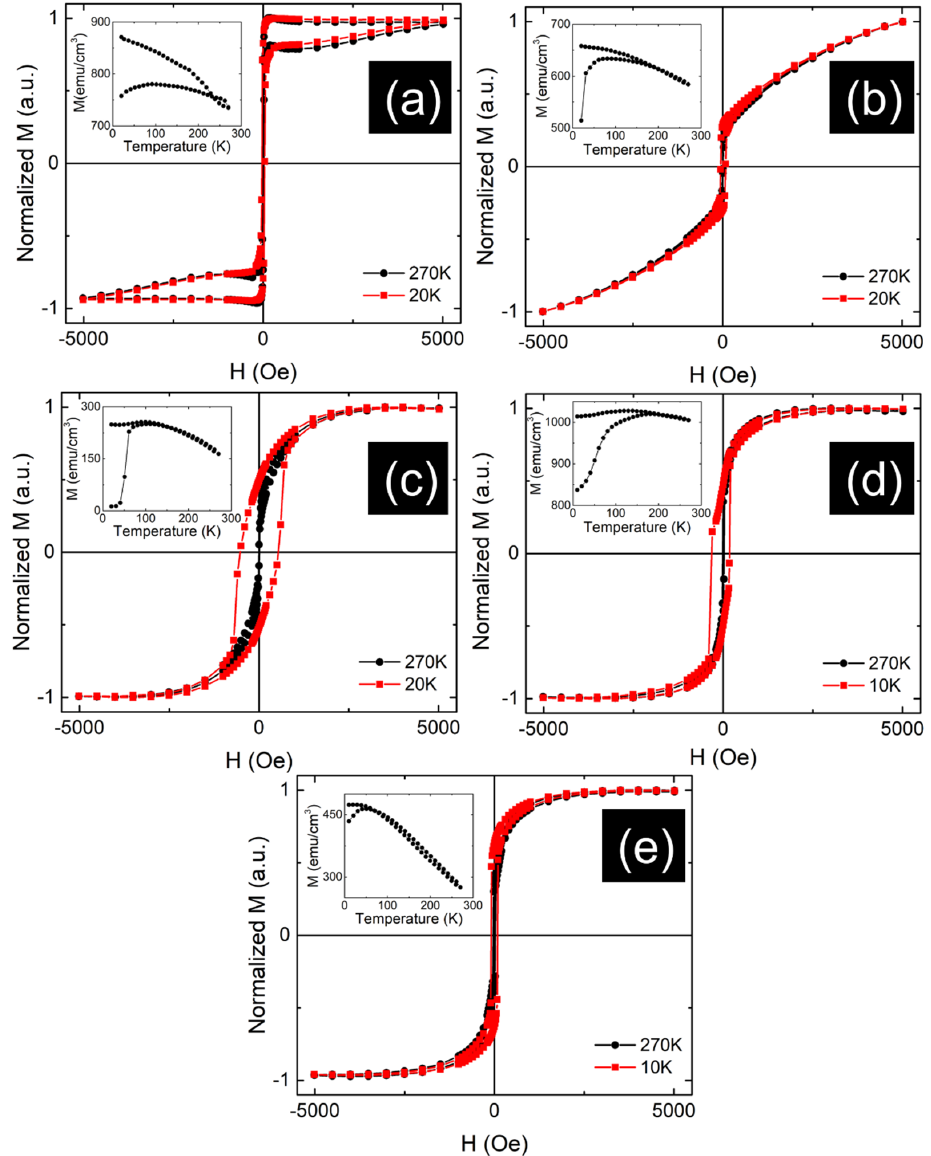
Figure 6. SQUID hysteresis loops of nanophase thin films ( a ) Au 70 Fe 30 _70, ( b ) Au 70 Fe 30 _17, ( c ) Au 70 Fe 30 _6, ( d ) Au 20 Fe 80 _70, and ( e ) Au 80 Fe 20 _70 (inset presents the ZFC-FC curves for each sample).